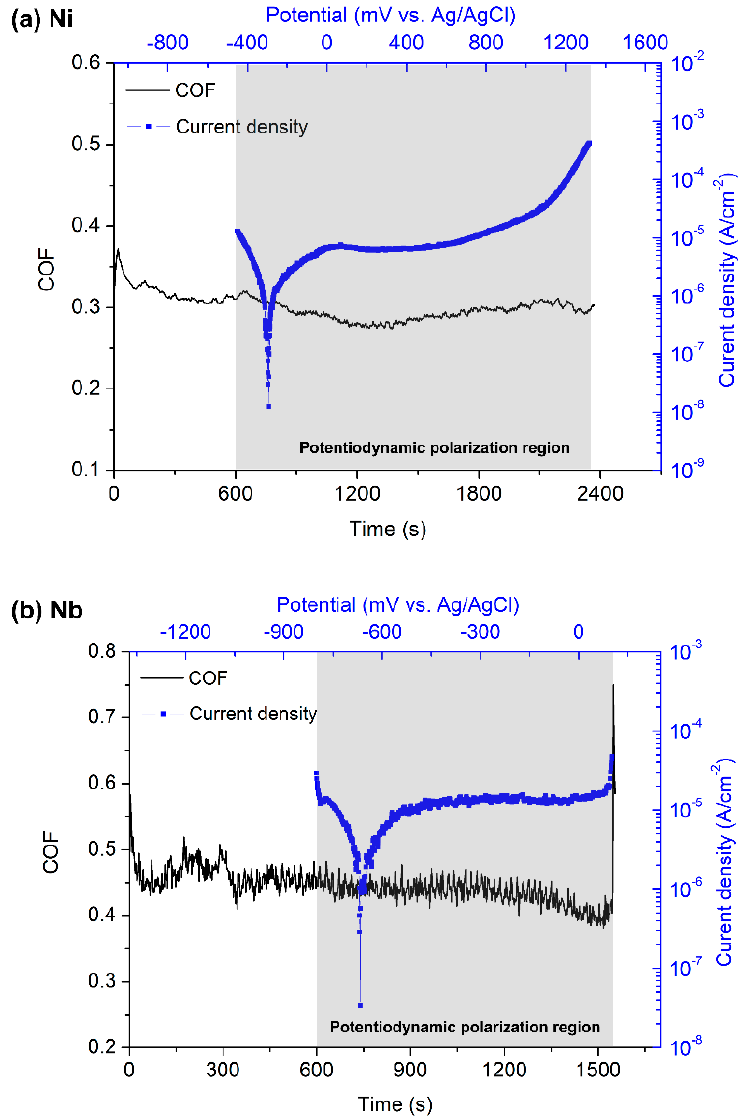
Figure 3. Evolutions of current and COF during the potentiodynamic tribocorrosion tests: ( a ) Ni and ( b ) Nb.